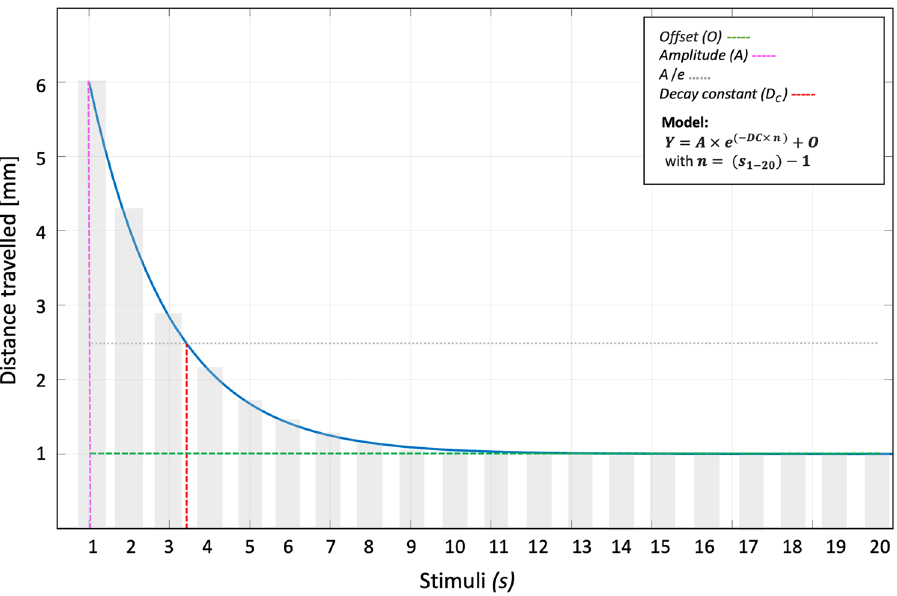
Figure 7. First-order exponential-fitting model used to describe the decay constant of startle